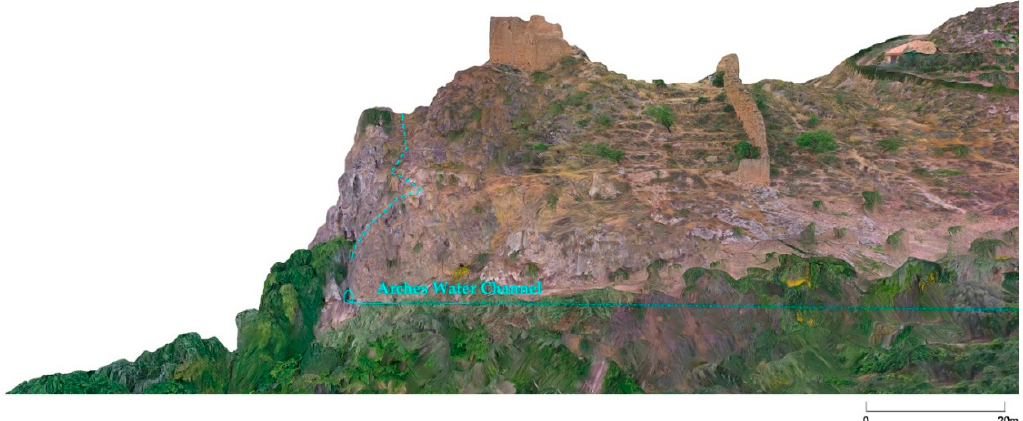
Figure 9. South-east prospect of the Alcazaba of Lojuela. Hypothesis on the coracha and detail of the Acequia de los Arcos. Created by authors.